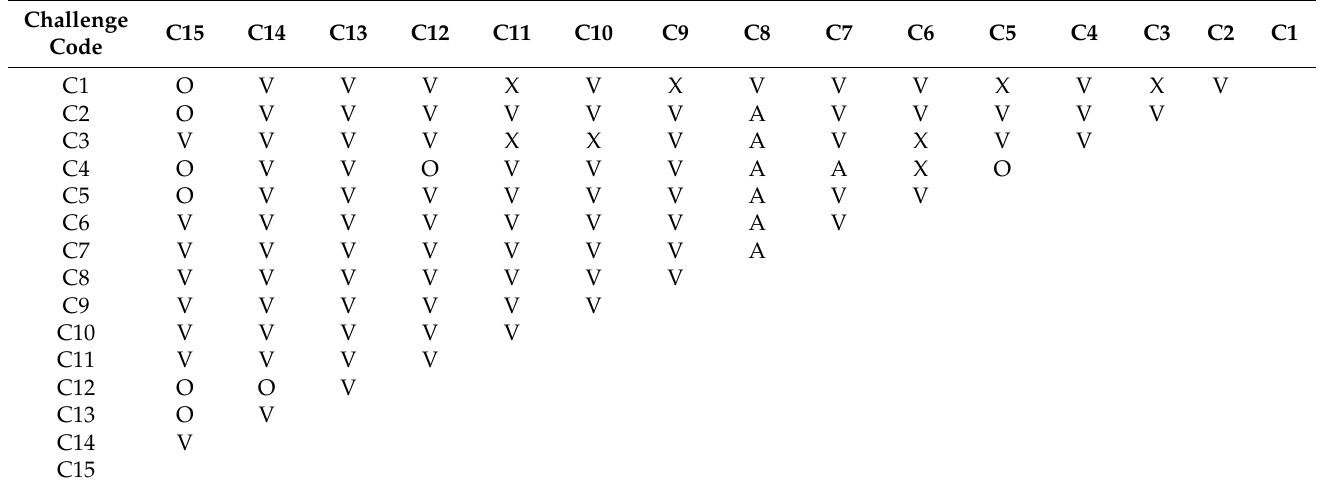
Table 3. SSIM matrix for